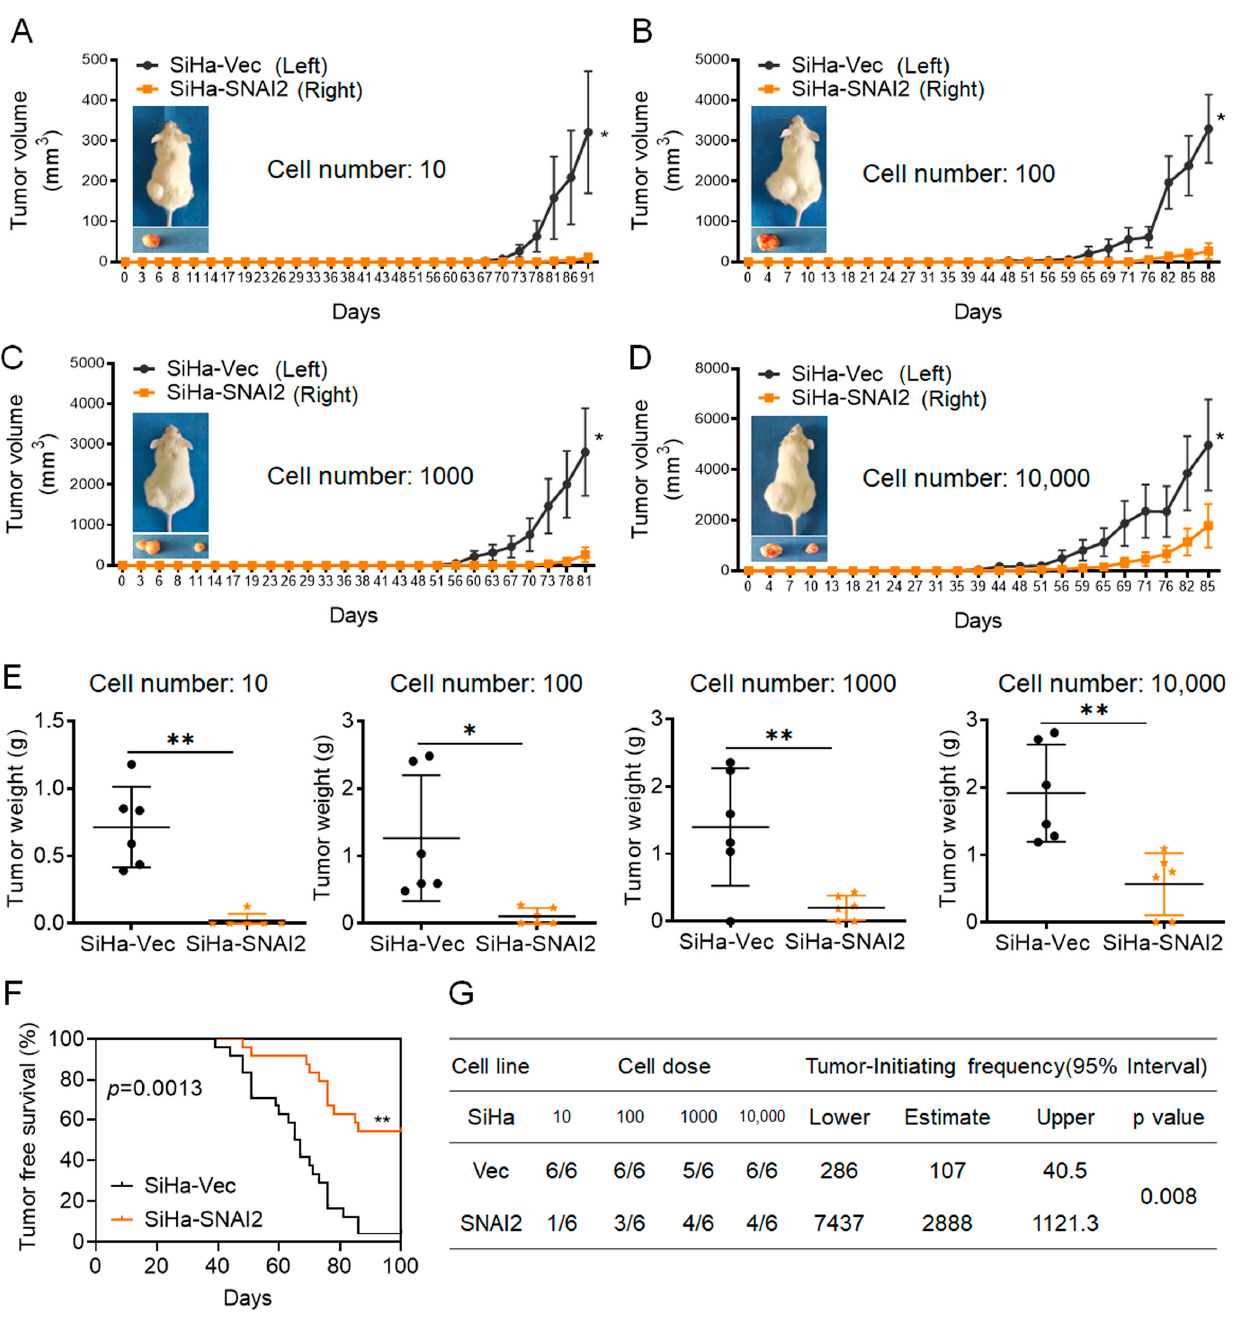
Figure 2. Tumorigenicity of SNAI2-modified SiHa cells in in NOD/SCID mice. The volume of xenograft tumors that formed from different numbers of SiHa-SNAI2 and SiHa-Vec cells: ( A ). 10, ( B ). 100, ( C ). 1000, ( D ). 10,000. ( E ). The weight of xenograft tumors that formed from different numbers of SiHa-SNAI2 and SiHa-Vec cells. ( F ). The tumor-free survival of the mice shown as Kaplan–Meier plots. ( G ). The tumor initiating frequency of SiHa-SNAI2 and SiHa-Vec cells. * p < 0.05, ** p < 0.01 vs. control.